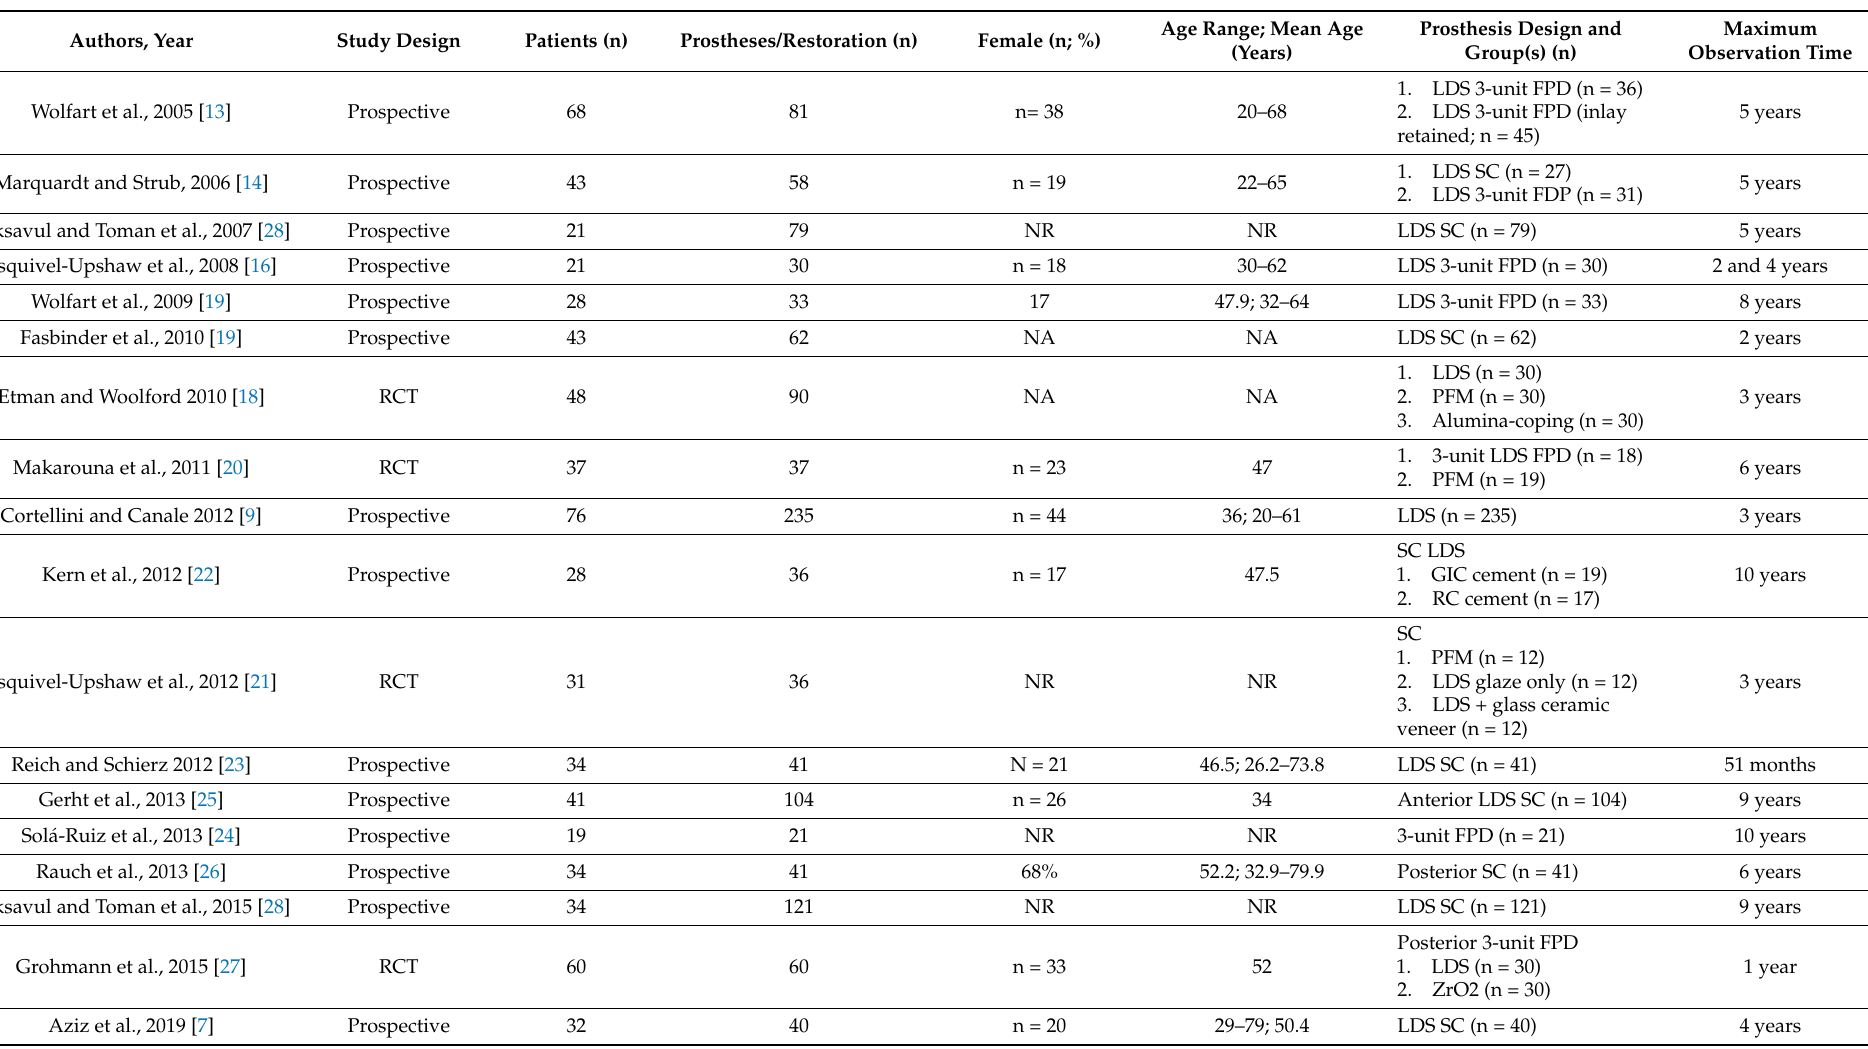
Table 1. General characteristics of the included